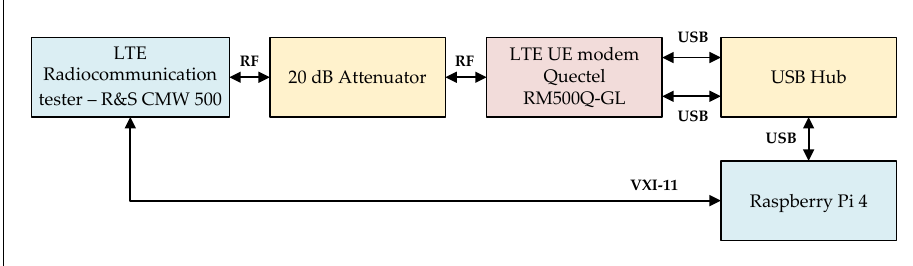
Figure 3. The measurement stand block